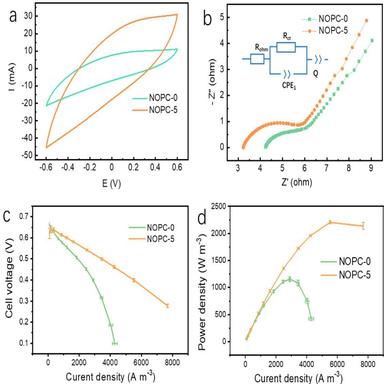
(a) Cyclic voltammograms (b) Nyquist plots of different electrodes in the anodic solution, insert of b is the parallel equivalent circuit; (c) polarization curve and (d) power output of different MFCs. In c and d, each value is the mean of two replicates.